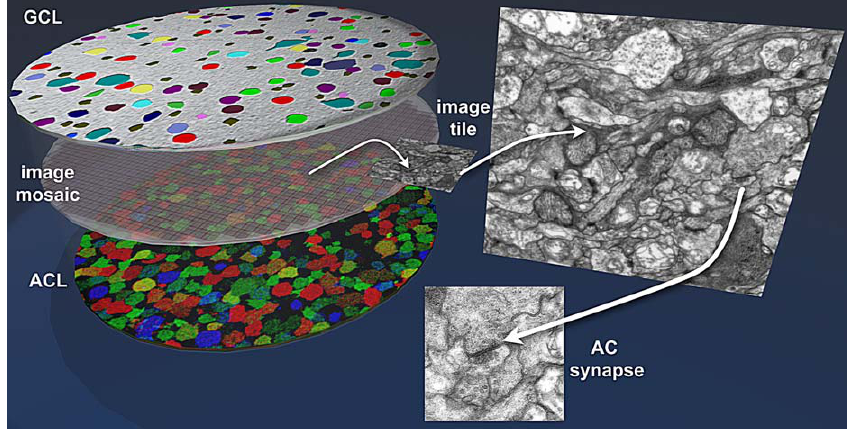
Figure 15. The Retinal CN Mapping Framework Canonical fields of rabbit retina are being sectioned from the GC to the AC layers at 70 nm and tiled mosaics acquired for volume assembly. Bounding the ssTEM set are classified sets of GCs (top) and ACs (bottom) whose processes enter the field and can be tagged and tracked. The GC patch is shown as a theme map and the AC patch as a c .AGB.E :: rgb mapped image. At 5,000 3 it is possible to unambiguously identify both conventional and ribbon synapses as well as most gap junctions that exceed ’ 200 nm in lateral extent. As CMP can be performed on sections as thin as 40 nm, selected molecular signals can be intercalated into ssTEM sets without significant disruption of volume builds by saving spaced sections for CMP, using them if needed, or reinserting them as ssTEM elements if not.